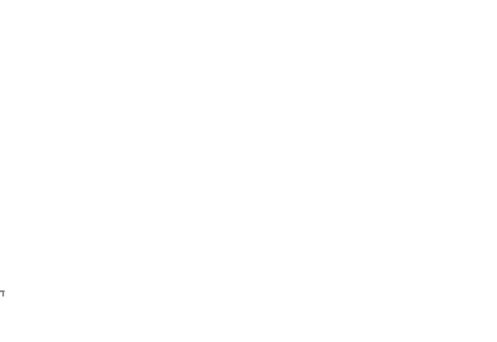
Figure 1. Comparison of median values of parabens included in the present